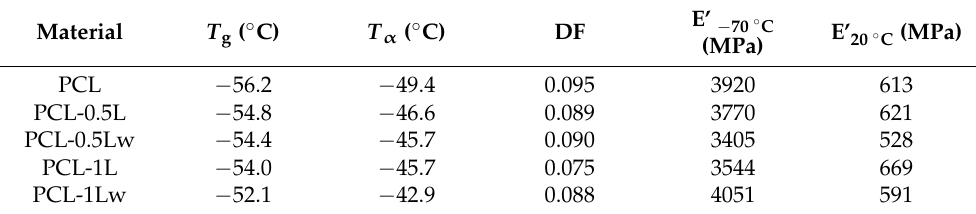
Table 3. DMTA main results of neat and reacted PCL recorded by DMTA Glass transition temper- ature ( T g ) as temperature of loss modulus peak maximum. Alpha transition temperature ( T α ) as temperature of tan δ peak maximum. Damping factor (DF) as the maximum of tan δ . Storage modulus (E’) values at − 70 and 20 ◦ C. Scattering of the data below 3%.